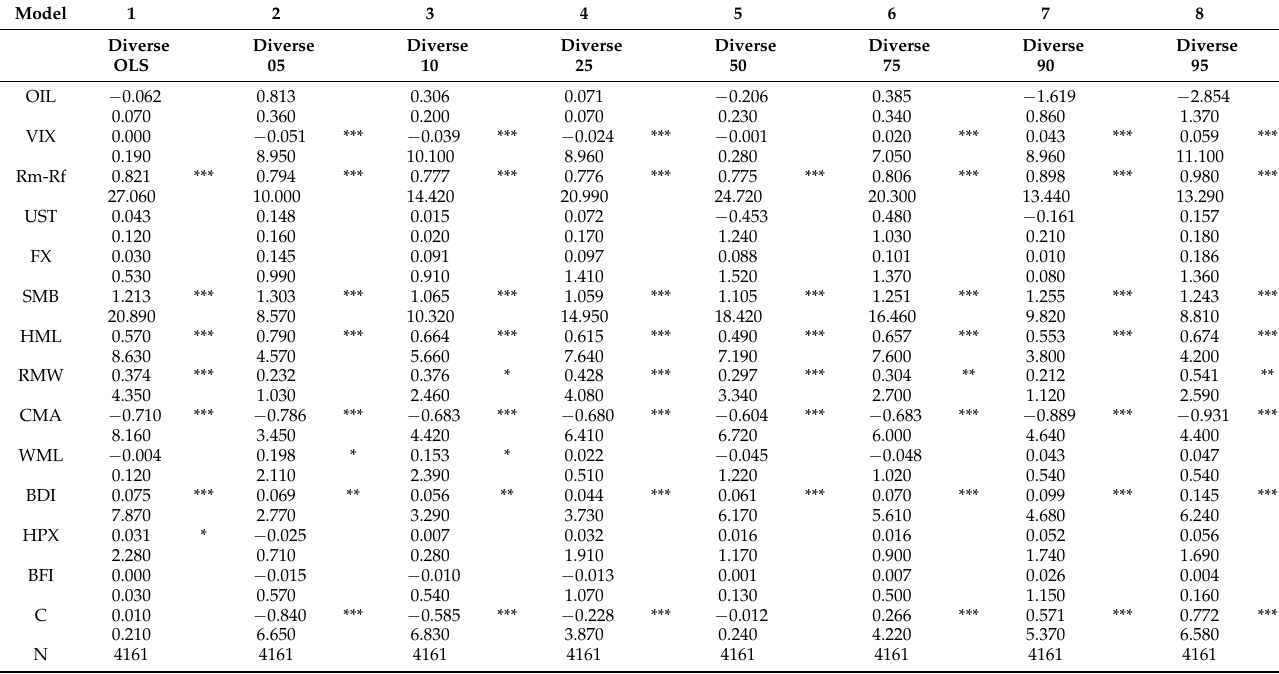
Table 7. Ordinary least square (OLS) and quantile regression estimates for the diversified